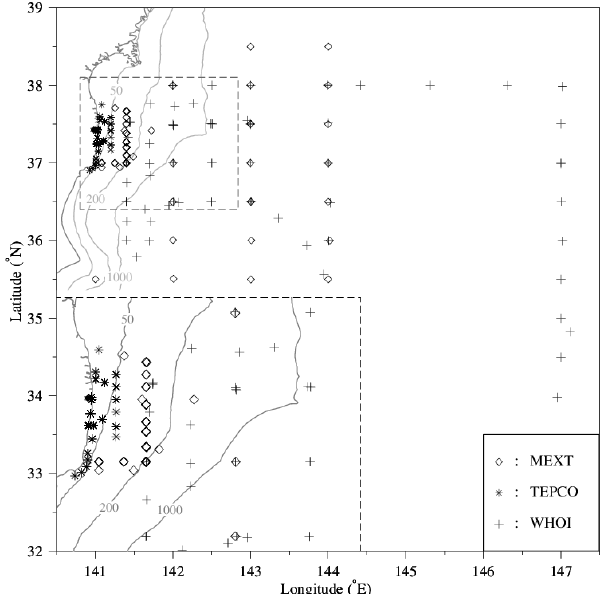
Fig. 3. Location of MEXT, TEPCO and WHOI monitoring and sur- vey measurement sites. Lower-left panel is an enlarged view of the nearshore monitoring sites bounded by a dashed line